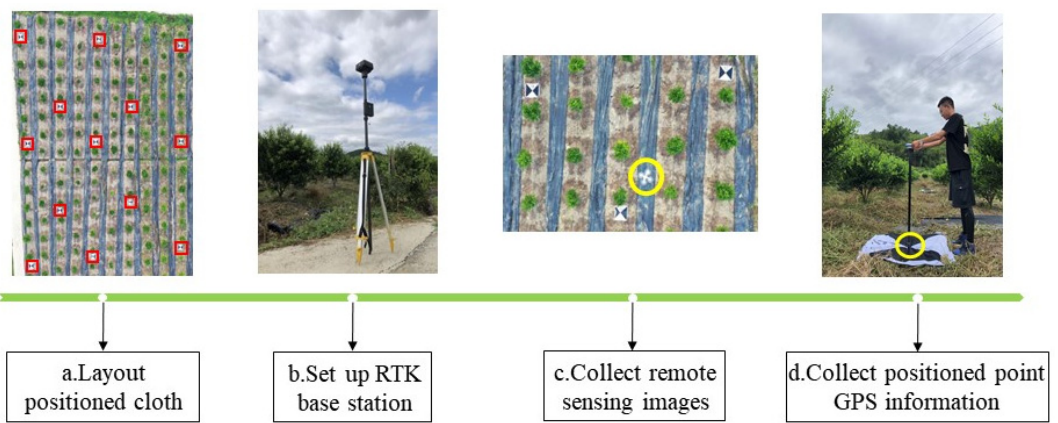
Figure 3. Flow chart of data acquisition.